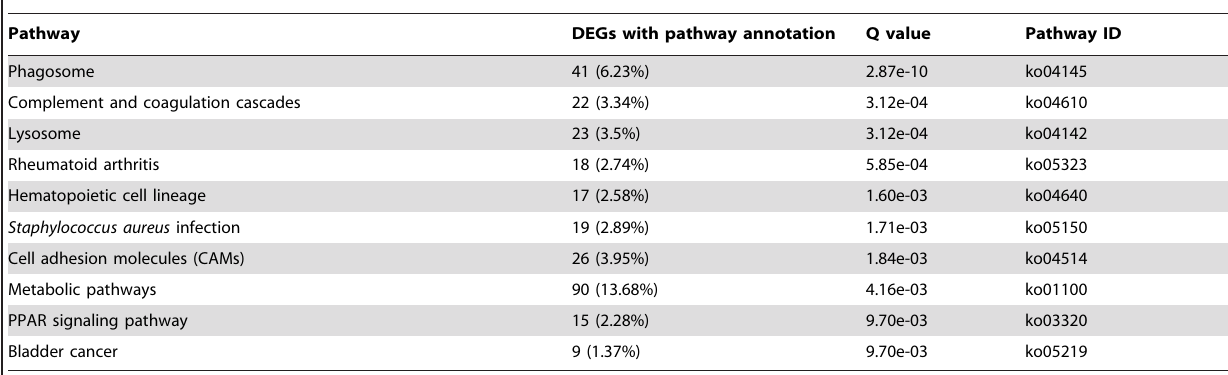
Table 2. Top 10 significantly enriched pathways at 2 7 d compared with 2 35 d.